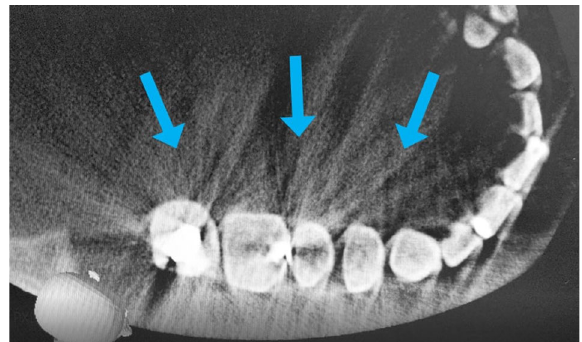
Fig. 2 CBCT scan of teeth with amalgam restorations. Hyperdense streaks exhibited on the teeth with amalgam restorations on a CBCT